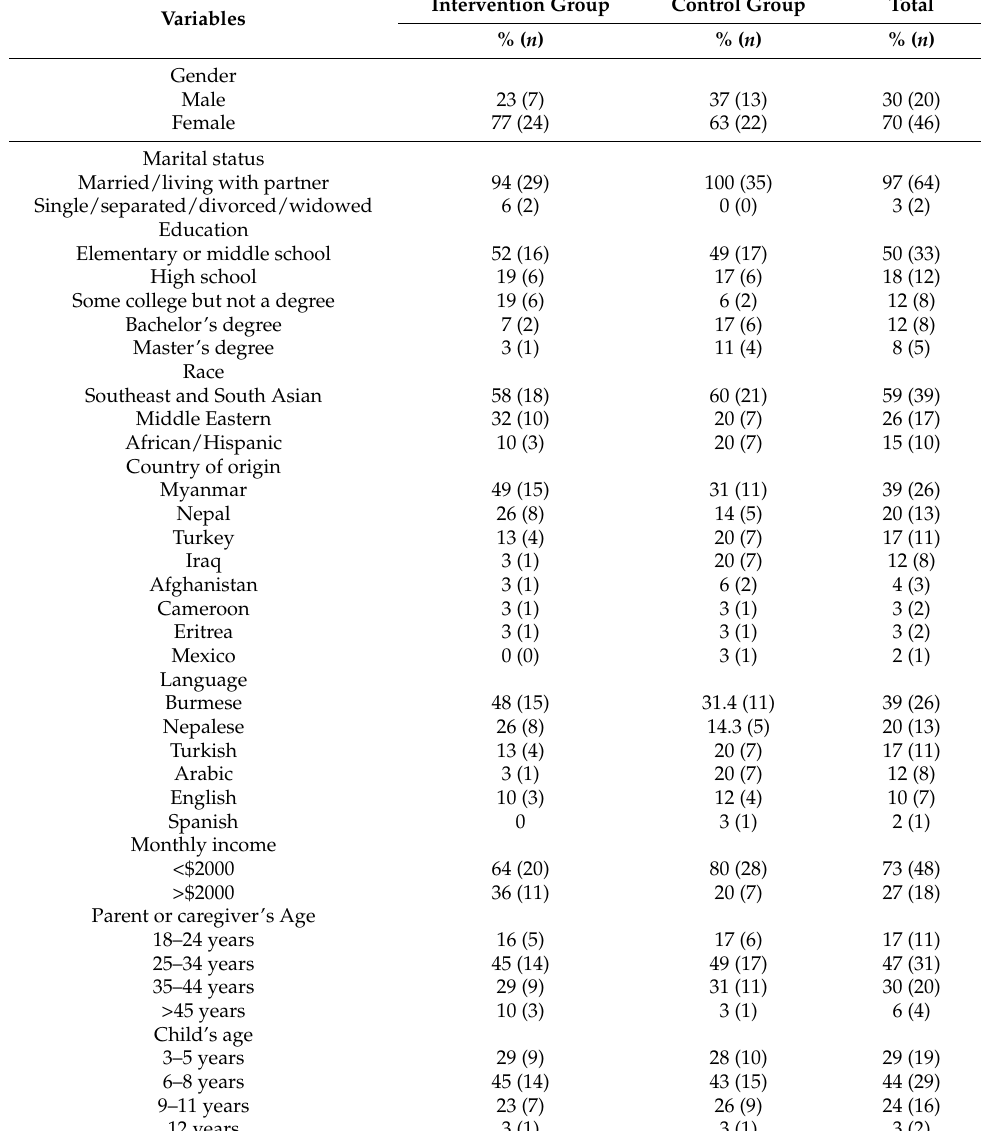
Table 1. Demographic characteristics of the